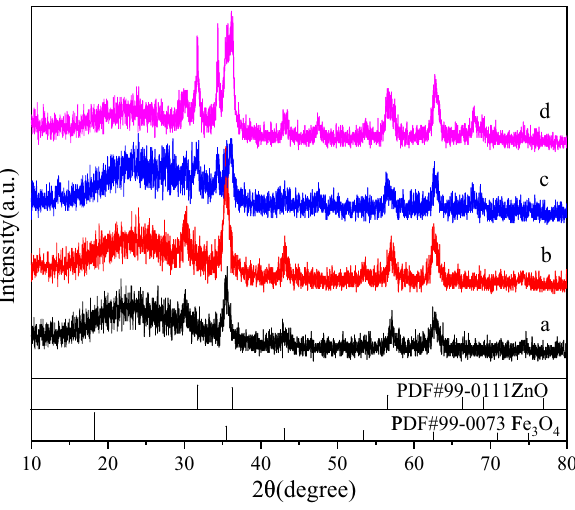
Figure 1: XRD characterization: ( a ) Fe 3 O 4 ; ( b ) Fe 3 O 4 @SiO 2 ; ( c ) Fe ( d ) Fe – ZnO. ( Zinc chloride was used as 3 O 4 @ZnO; 3 O 4 @SiO 2 zinc source ) .